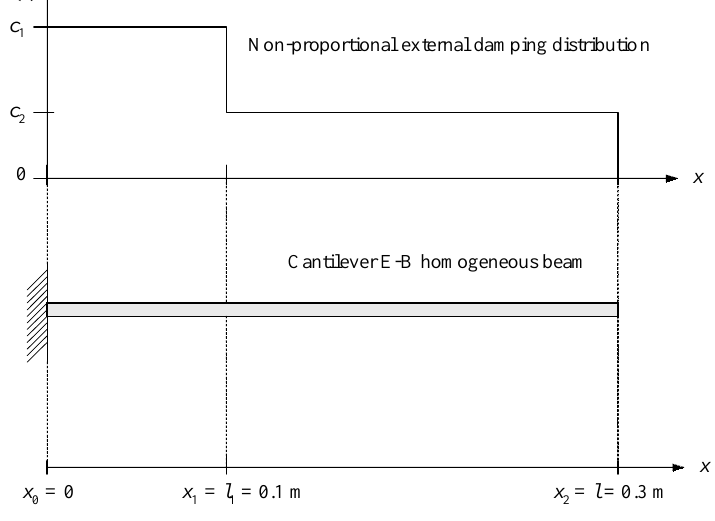
Fig. 1. Cantilever homogeneous beam with non-proportional external damping.